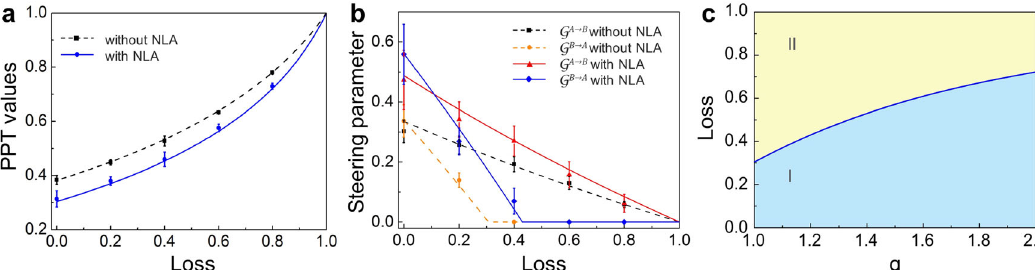
Fig. 2 Results for the distillation in a lossy channel. The PPT values a and the Gaussian EPR steering b with and without the NLA based on Bob ’ s measurement results, respectively. c The EPR-steerable regions parameterized by loss and gain with the NLA based on Bob ’ s measurement results in a lossy channel. The blue and yellow regions are the two-way steerable region (I) and one-way steerable region (II), respectively. Error bars correspond to one standard deviation from statistical